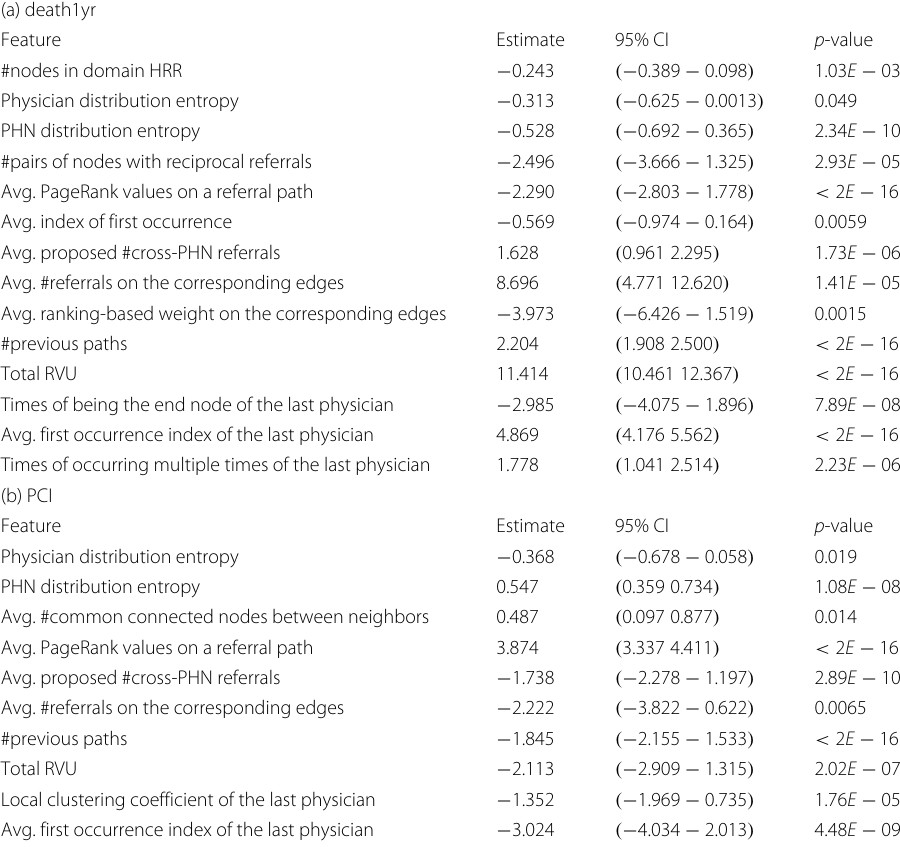
Table 15 Significant predictors for LR on two binary treatment variables with estimated coefficients in 95% confidence interval